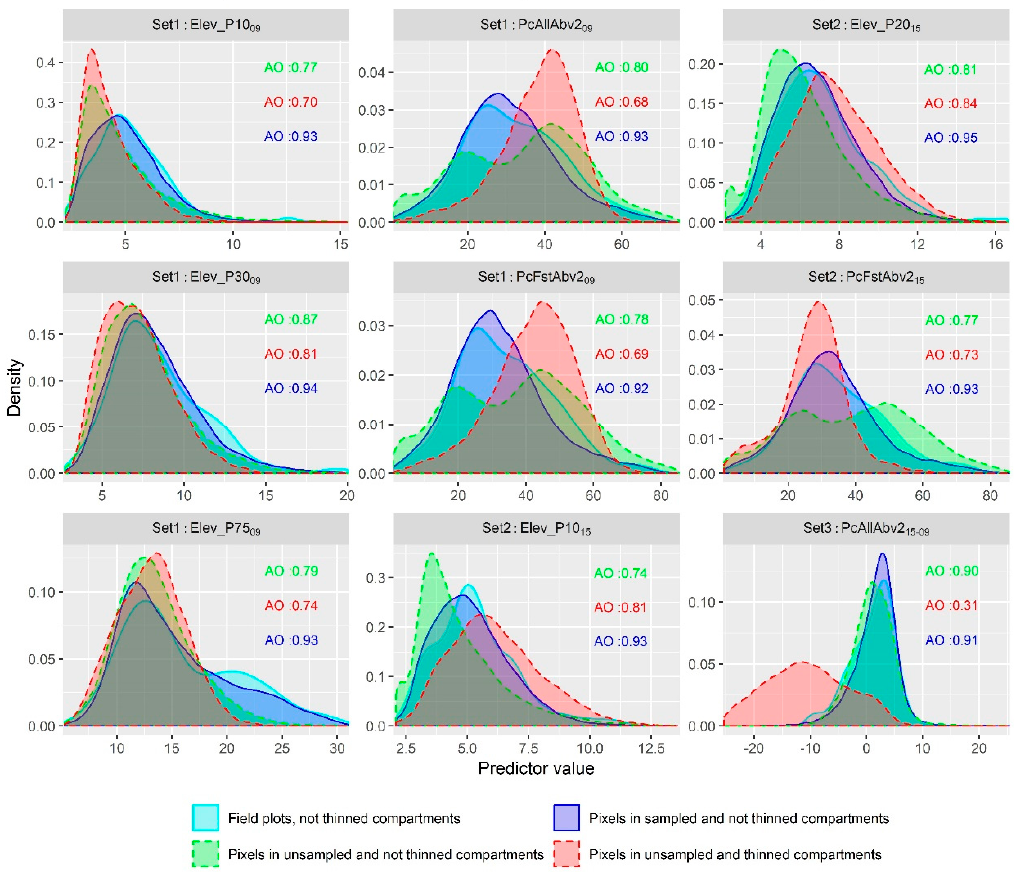
Figure A4. Comparison of density functions for the predictors in the models used to estimate changes in Basal Area using the δ -modeling method and y -modeling method in field plots (light blue), sampled and not thinned stands (dark blue), unsampled and not thinned stands (light blue) and unsampled and thinned stands (red). For each group the area of overlap, AO, with the density function for the field plots (green) is provided for each predictor.